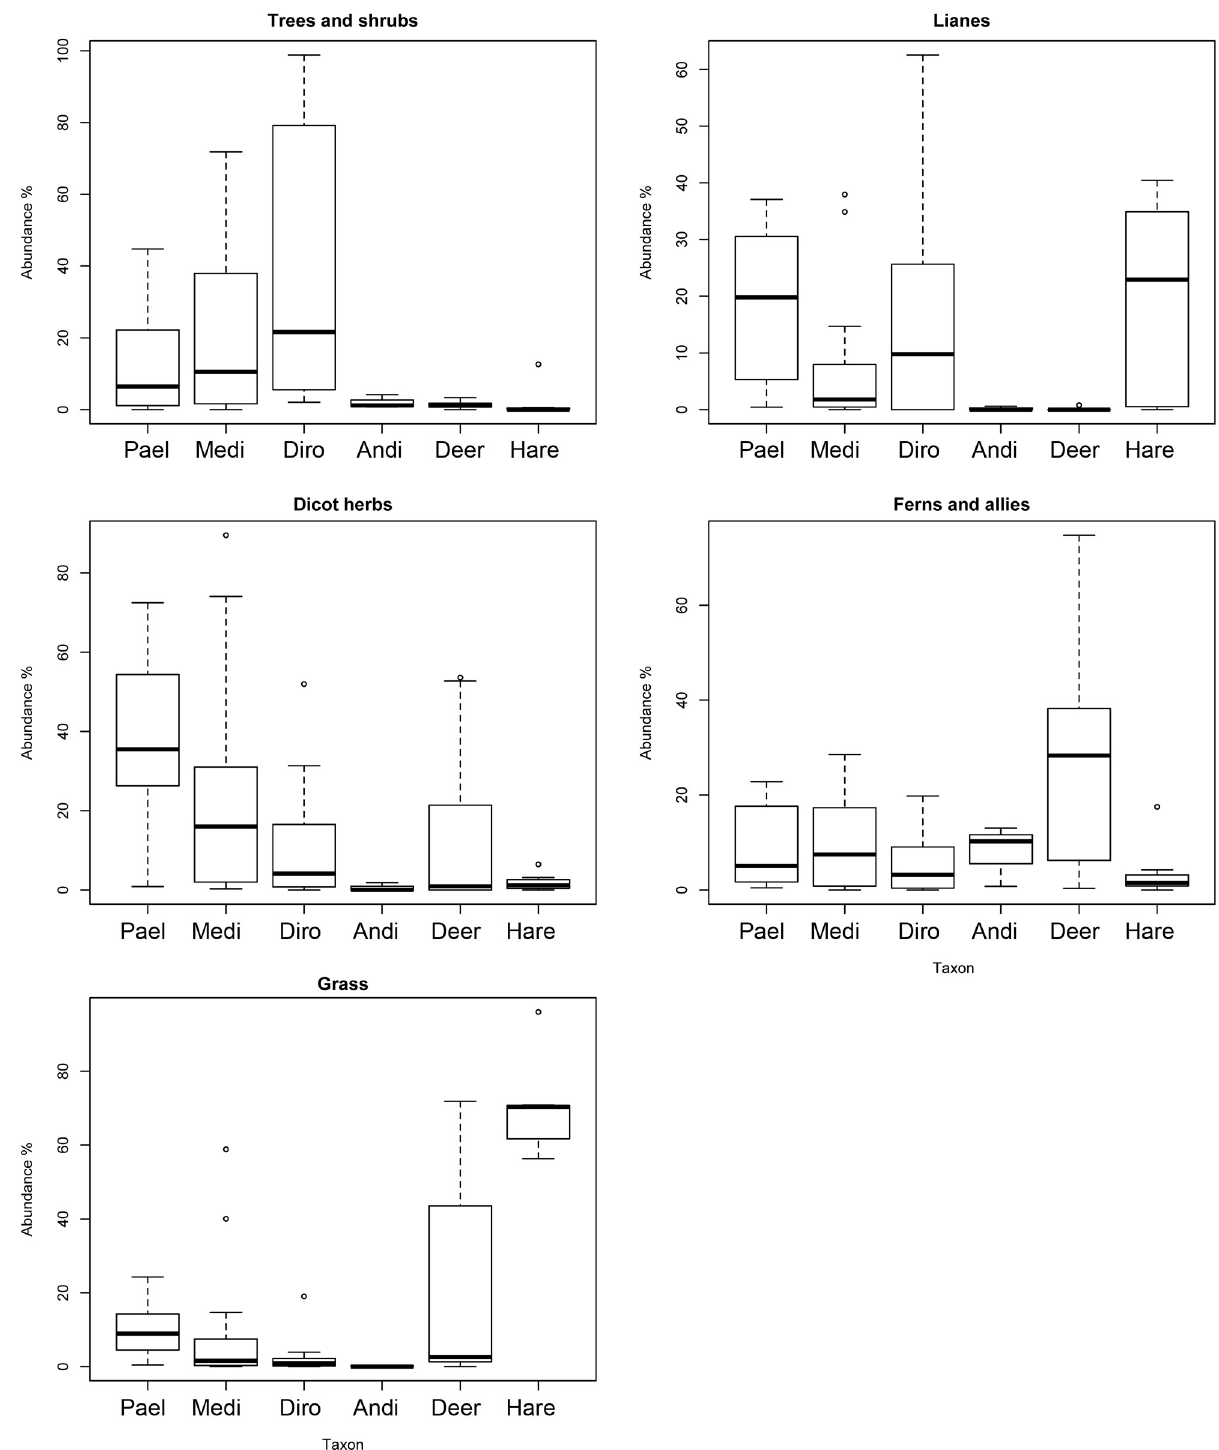
Fig 4. Relative abundance of pollen and spore assemblages attributed to different plant groups. Moa coprolites (Pael, Pachyornis elephantopus ; Medi, Megalapteryx didinus ; Diro, Dinornis robustus ; Andi, Anomalopteryx didiformis ) and deer and hare pellets from Daley’s Flat rock avalanche deposit. Fuscospora pollen is excluded due to its tendency to be over-represented in samples.